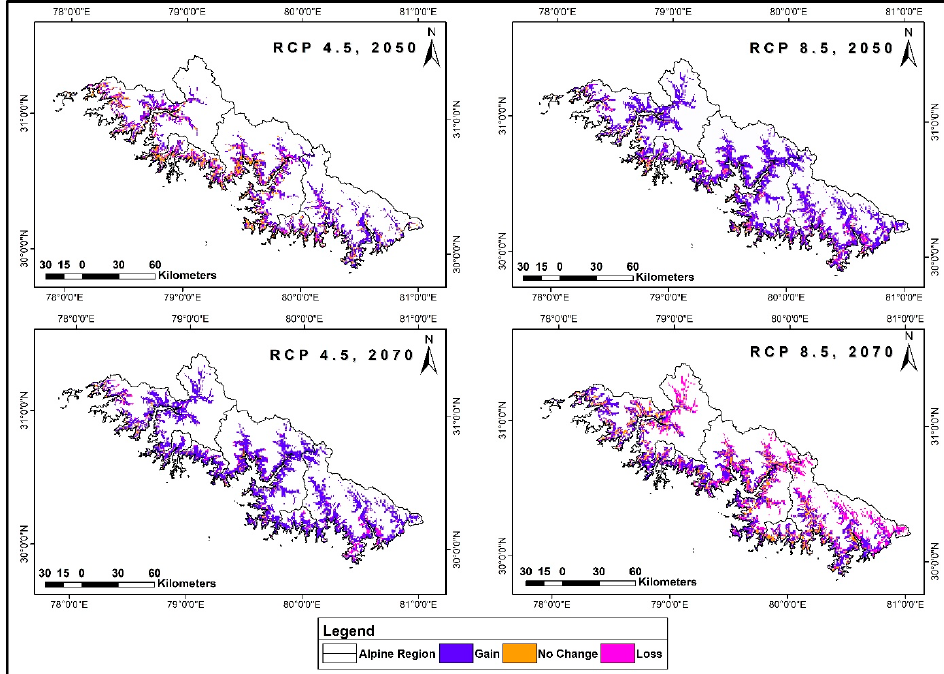
Figure 8. Predicted range contraction for C. himalaicum.